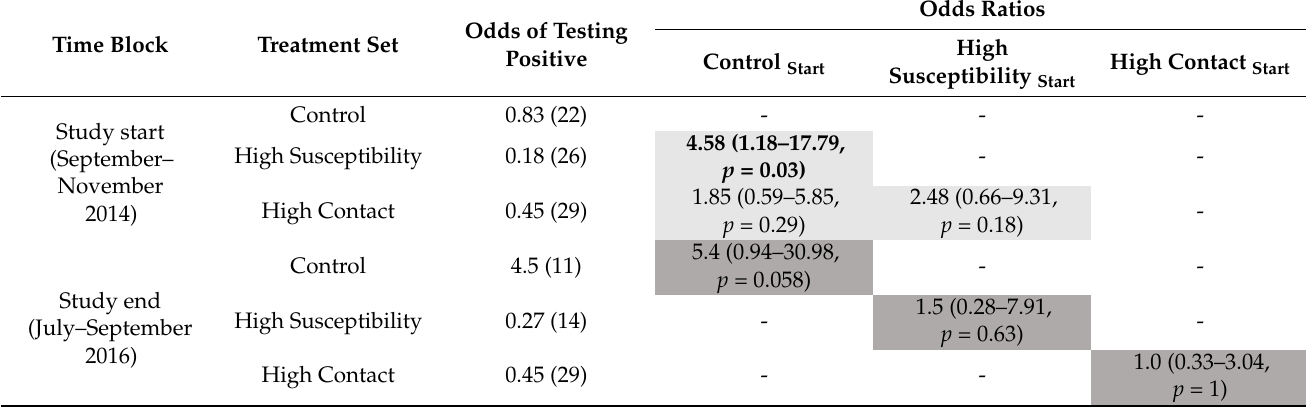
Table 1. Odds of testing positive for TB in groups of meerkats receiving no vaccination (control) or trait-based targeted vaccination regimes (high susceptibility and high contact). The odds of an individual testing positive (with the sample size in brackets) are shown in the third column for each treatment set at both the start and the end of the study, excluding vaccinated animals. An individual was considered test positive if it generated a positive result on any one of the three diagnostic